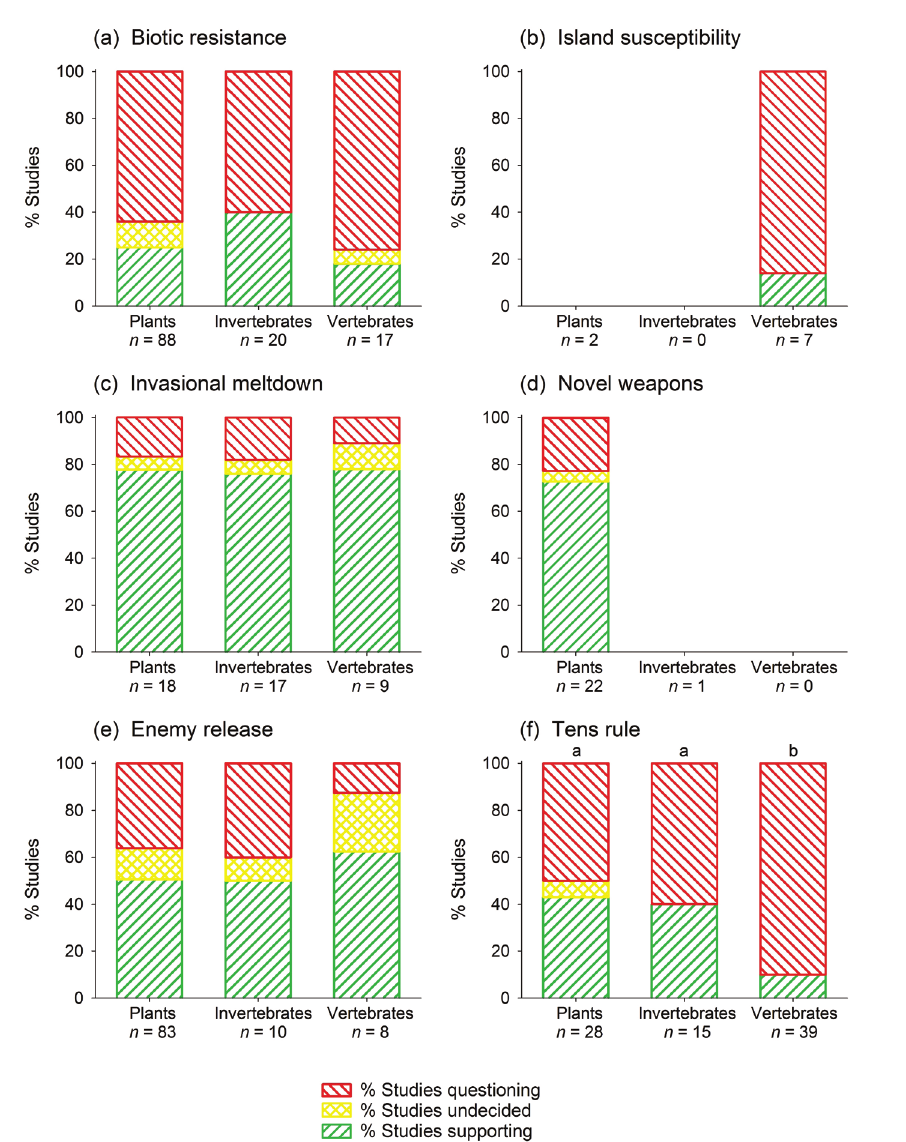
Figure 4. Level of empirical support for six of invasion biology’s major hypotheses, subdivided by taxo- nomic groups. The few cross-taxonomic studies that covered more than one of the three indicated taxo- nomic groups were counted for each group. Missing bars indicate lacking data: bars are shown only if at least five studies were carried out for a given hypothesis and taxonomic group. Letters in (f) indicate significant differences between taxonomic groups (U tests, p < 0.01). No significant differences were ob- served for the other